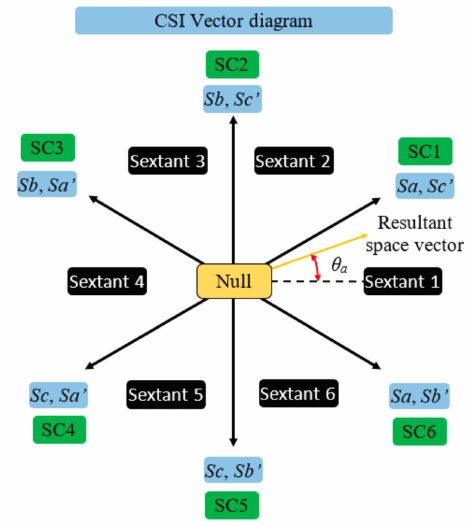
Figure 4. Space vector representation of the active states of the CSI. Sextant 1 is delimited by the active States of Commutation (SC) SC6 and SC1. These active states correspond to the line voltages v ab and v ac , respectively, and the angle θ a of the resultant vector in vector space has the range − π /6 ≤ θ a ≤ π /6. In this way, the line voltages are obtained from the voltage in the virtual dc-link by commuting the switches Sa , Sb’ and Sa , Sc’ of the inverter. The phase angle orientation of the CSI output voltages is synchronized with the difference between the phase angle of the reference voltages and the phase angle measured on the load. Three-phase output voltages are defined